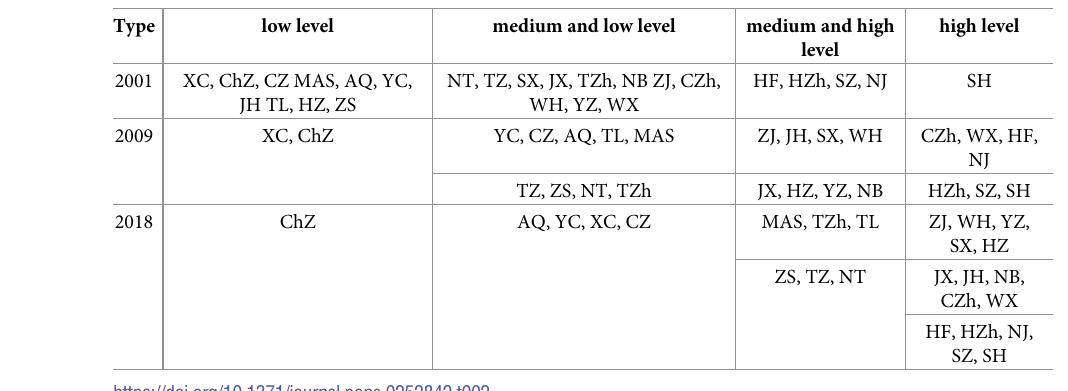
Table 2. Type classification of